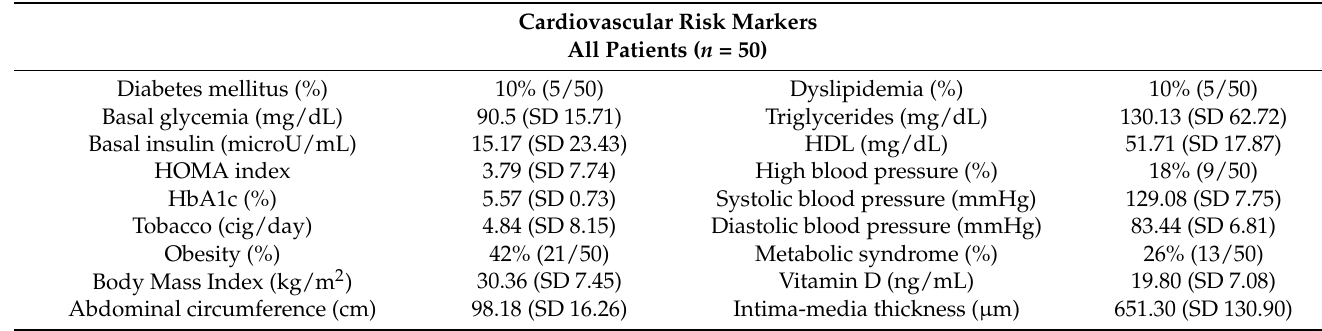
Table 2. Cardiovascular risk markers in the sample. Cardiovascular Risk Markers